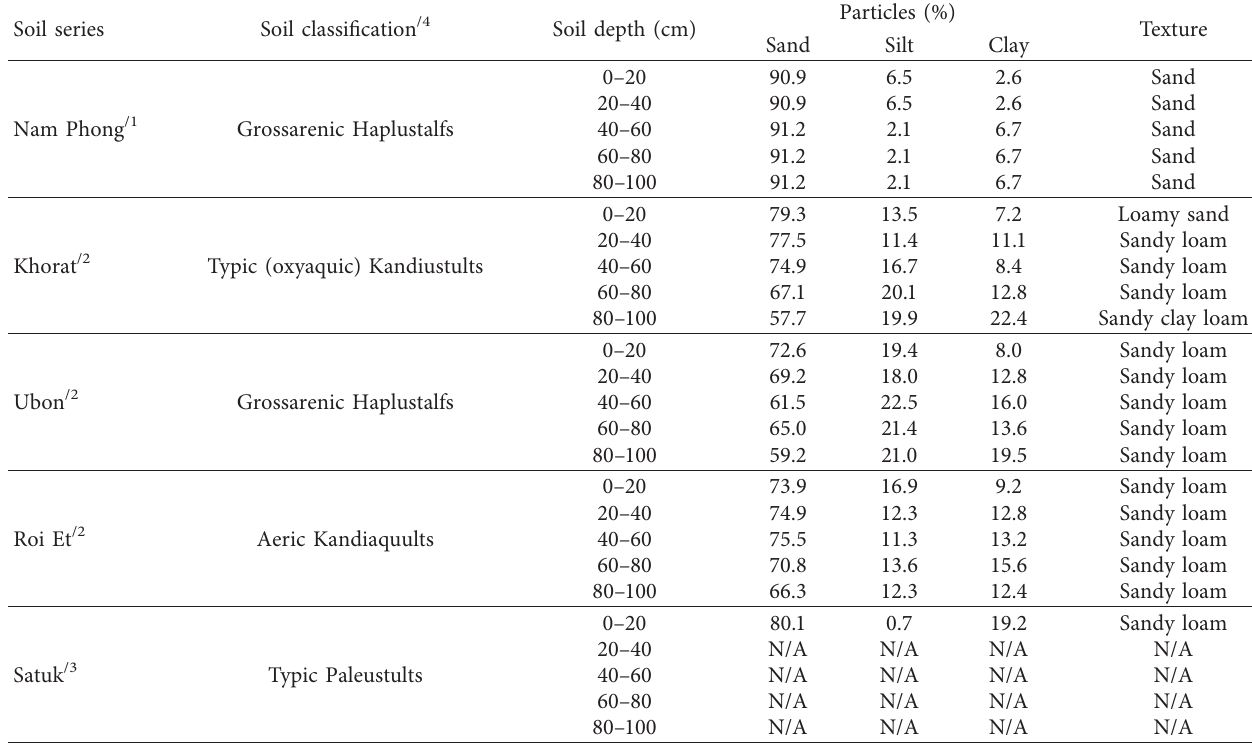
Table 2: Some soil characteristics in this study.